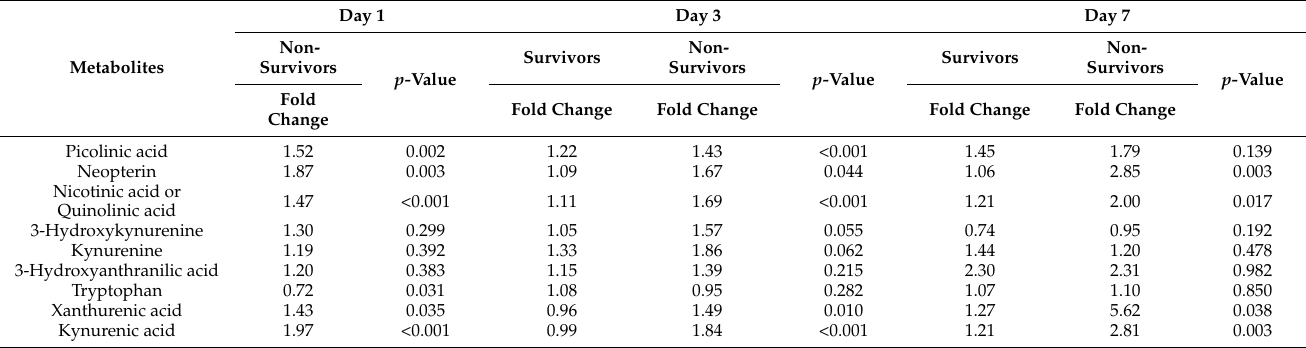
Table 3. Urine metabolites of tryptophan degradation at day 1, day 3, and day 7 after ARDS onset, compared to survivors at day 1.